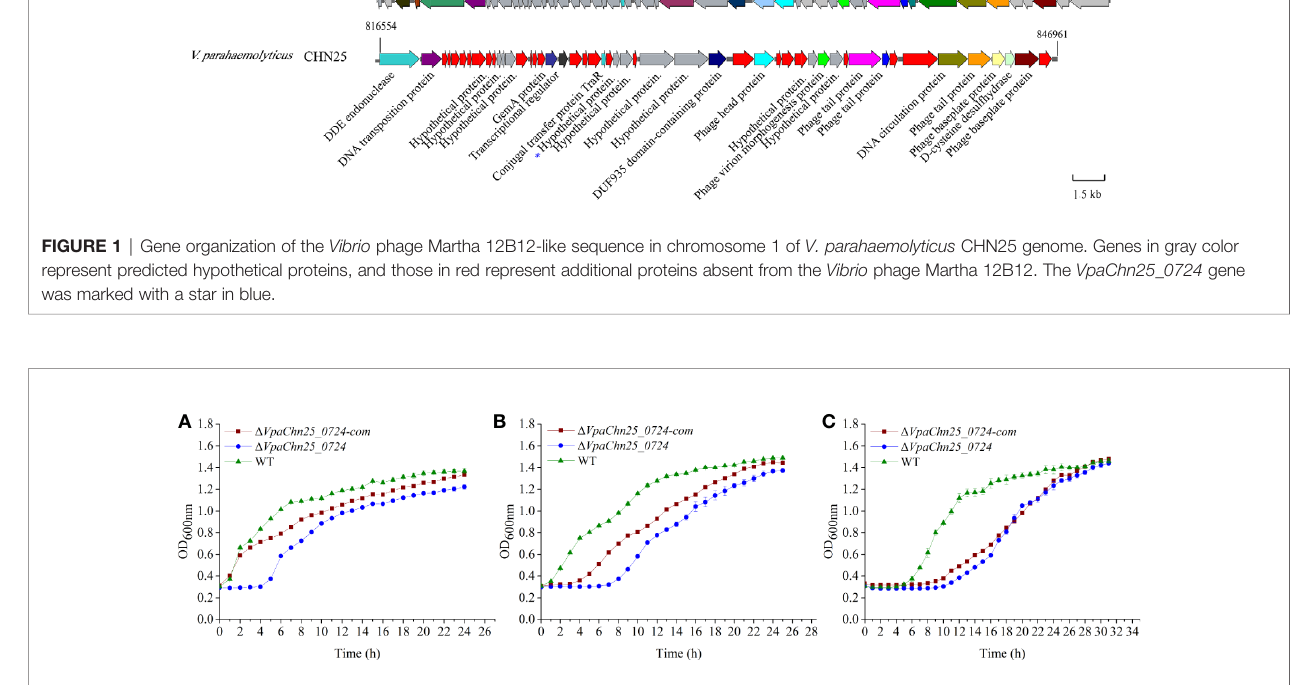
FIGURE 2 | Survival of V. parahaemolyticus CHN25 (WT), D VpaChn25_0724 , and D VpaChn25_0724 -com strains at different temperatures. The strains were incubated in the TSB medium at 37°C (A) , 25°C (B) , 15°C (C) , respectively. WT, wild type.